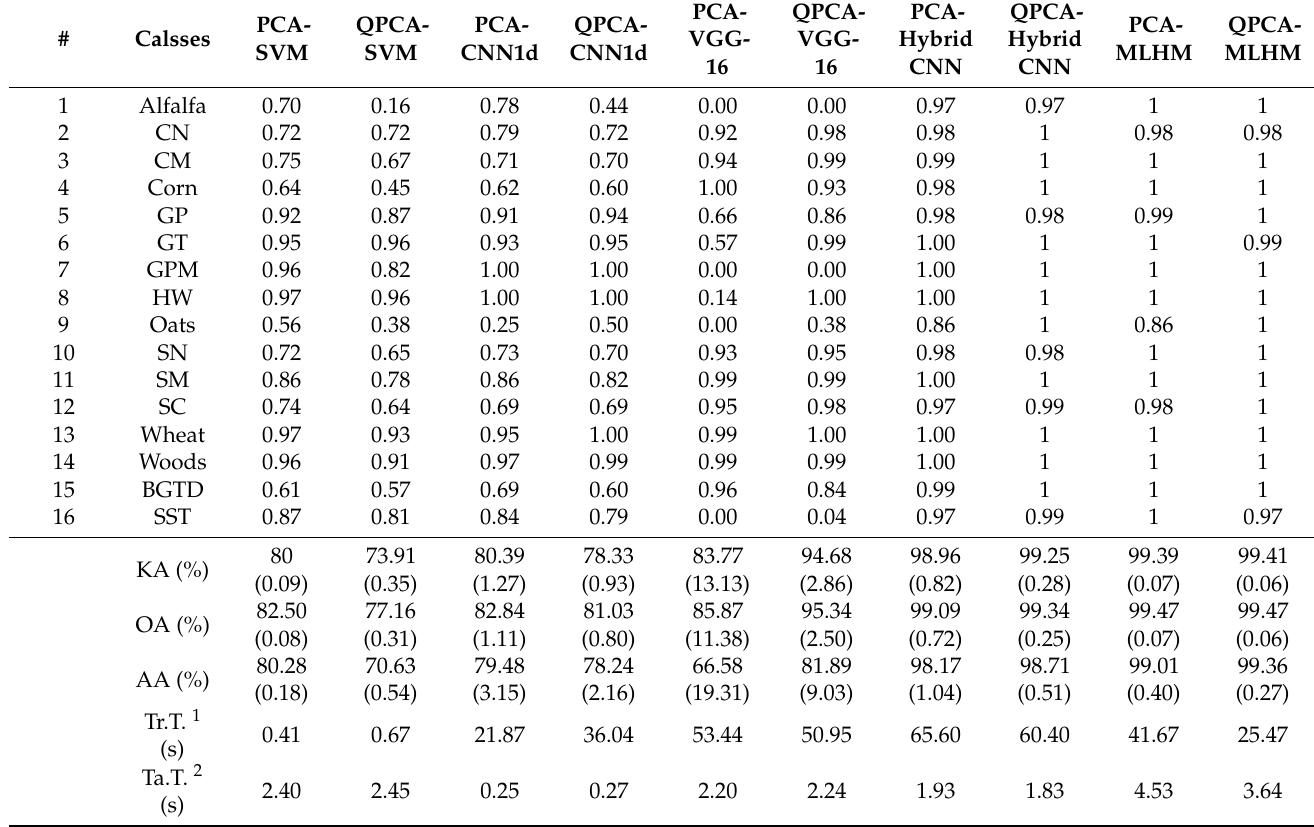
Table 6. The comparison of the various models with PCA and QPCA preprocessing for the IPs dataset.